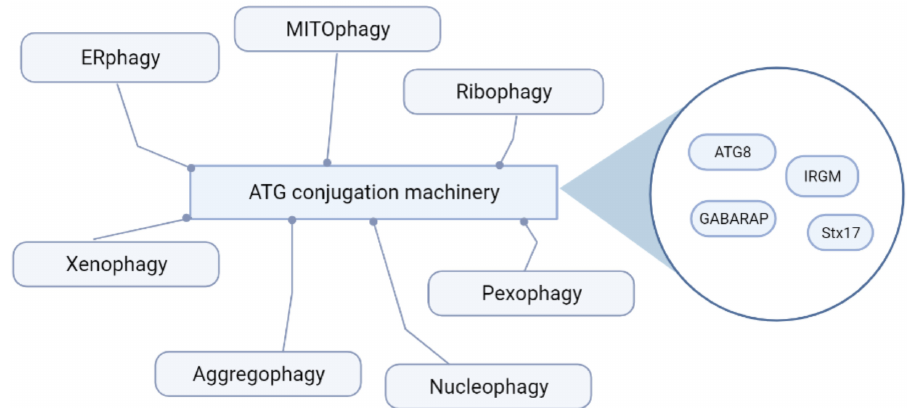
Figure 2. Distinct autophagic routes. Depending on the specific structures and cargoes initiating autophagy, different autophagic routes have been elucidated.